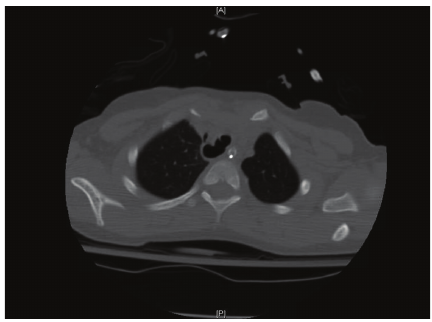
Figure 1: Hospital Day number 2. Noncontrast CT scan of chest. Extensive pneumomediastinum has diminished. There is a persis- tent right posterolateral tracheal wall defect/tracheal diverticulum.